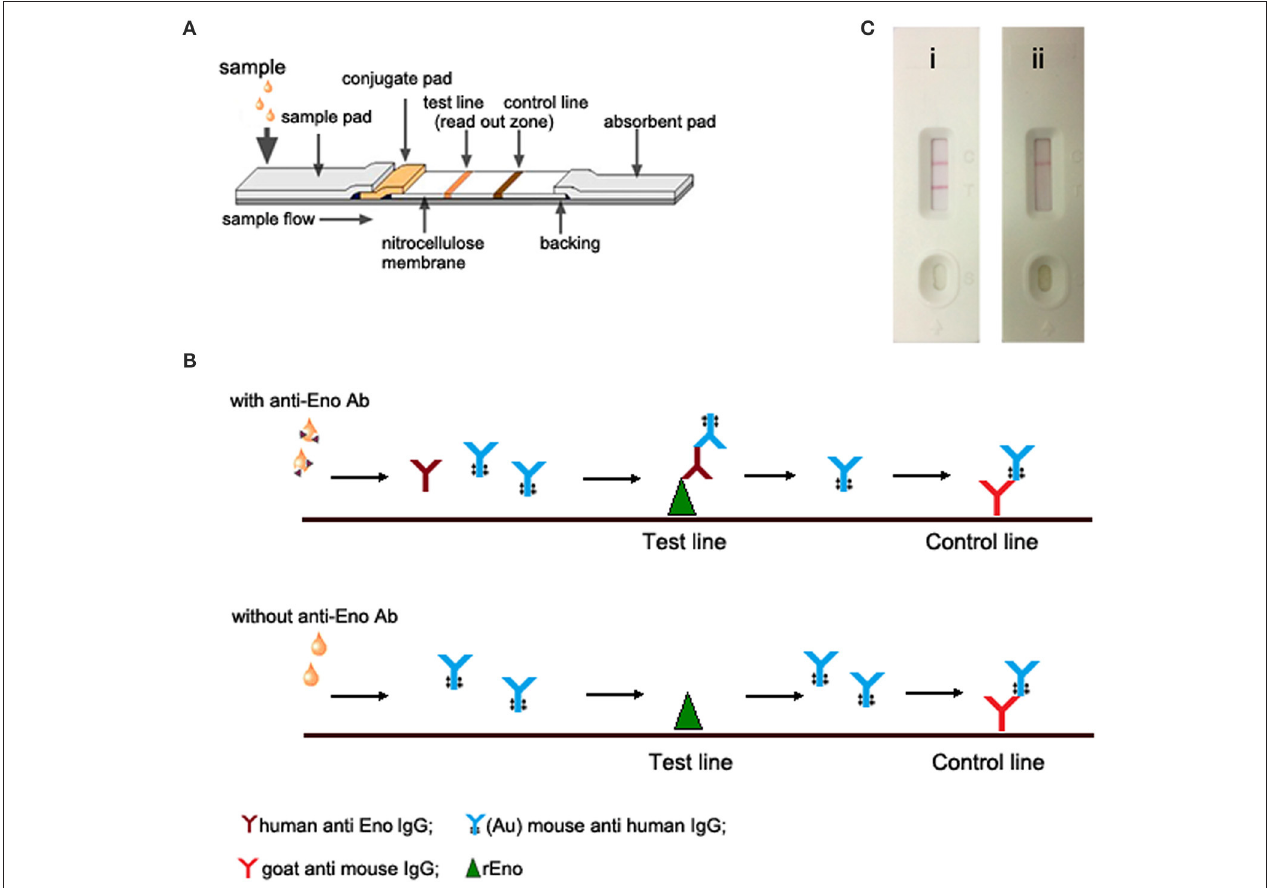
FIGURE 1 | Design of the lateral flow immunoassay strip. (A) Schematic diagram. The conjugate pad was dispensed with gold conjugated mouse anti human antibody solution. At the test line and control line position, rEno and goat anti mouse IgG were immobilized, respectively. (B) The test principle of the lateral flow immunoassay strip. Human anti Eno IgG present in the sample react and bind to the gold conjugated mouse anti human IgG, then, it was captured by immobilized rEno, forming a positive result in the test line. Immobilized goat anti mouse IgG captures gold-conjugated mouse anti human IgG, forming the control line. (C) Interpretation of the results. i, positive (2 red bands at the readout zone) and ii, negative (only the control line area shows a red band).